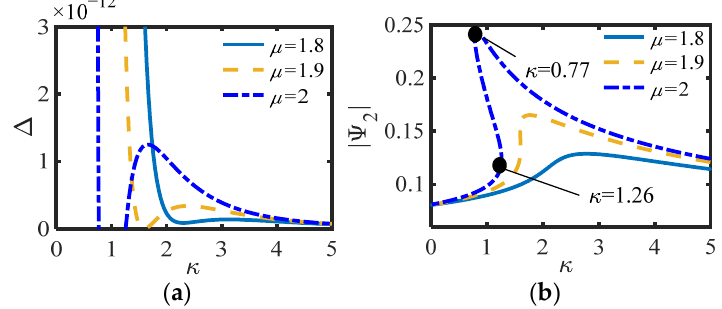
Figure 9. ( a ) Δ and ( b ) | Ψ 2 | of S.2 vs. κ for different μ ( c s = 0.3).